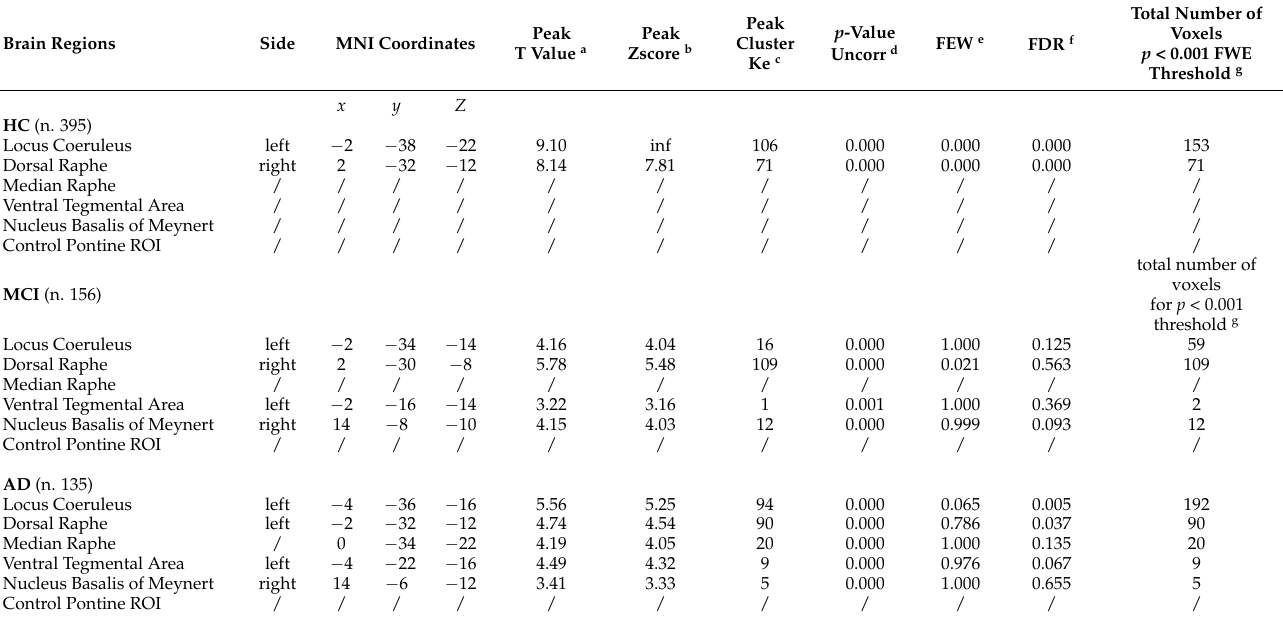
Table 3. VBM multivariate linear regression analyses for the six ROIs across the three groups (HC n = 395; MCI n = 156; AD n = 135). The results were adjusted for total intracranial volume (TIV), while age and education were entered as continuous variables. BrainPAD values were treated as the continuous dependent variable and the structural scans as the independent variable. For a statistical threshold of p < 0.001 FWE corrected (HC) and p < 0.001 (MCI and AD), the table reports the significant voxels negatively related to